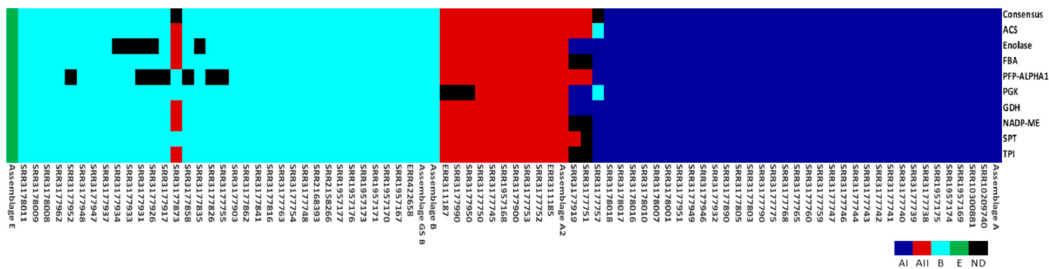
Figure 3. Allele plot constructed for with the alignment of the concatenated genomic sequences and for each gene. Colours indicate AI, AII, B, E, and ND (Not determined) assemblages. Each column corresponds to a genome and each row is a genetic marker. The assemblages were assigned depending on clusters obtained in the phylogenetic tree of each gene.